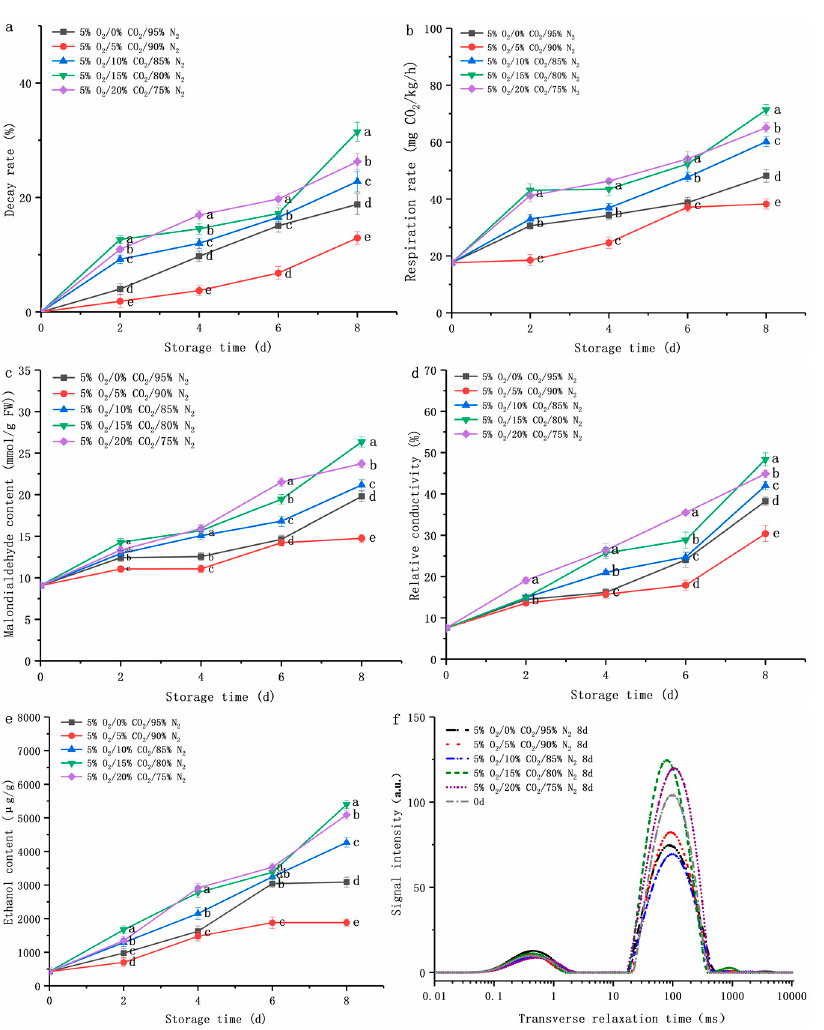
Figure 2. Effect of CO 2 concentration (%) with 5% O 2 on decay rate ( a ), respiration rate ( b ), malondialdehyde content ( c ), relative conductivity ( d ), ethanol content ( e ), and transverse relaxation time ( f ) of fresh-cut Dictyophora rubrovolvata . Differences at p < 0.05 are indicated by different letters and data are expressed as the mean ± SD.